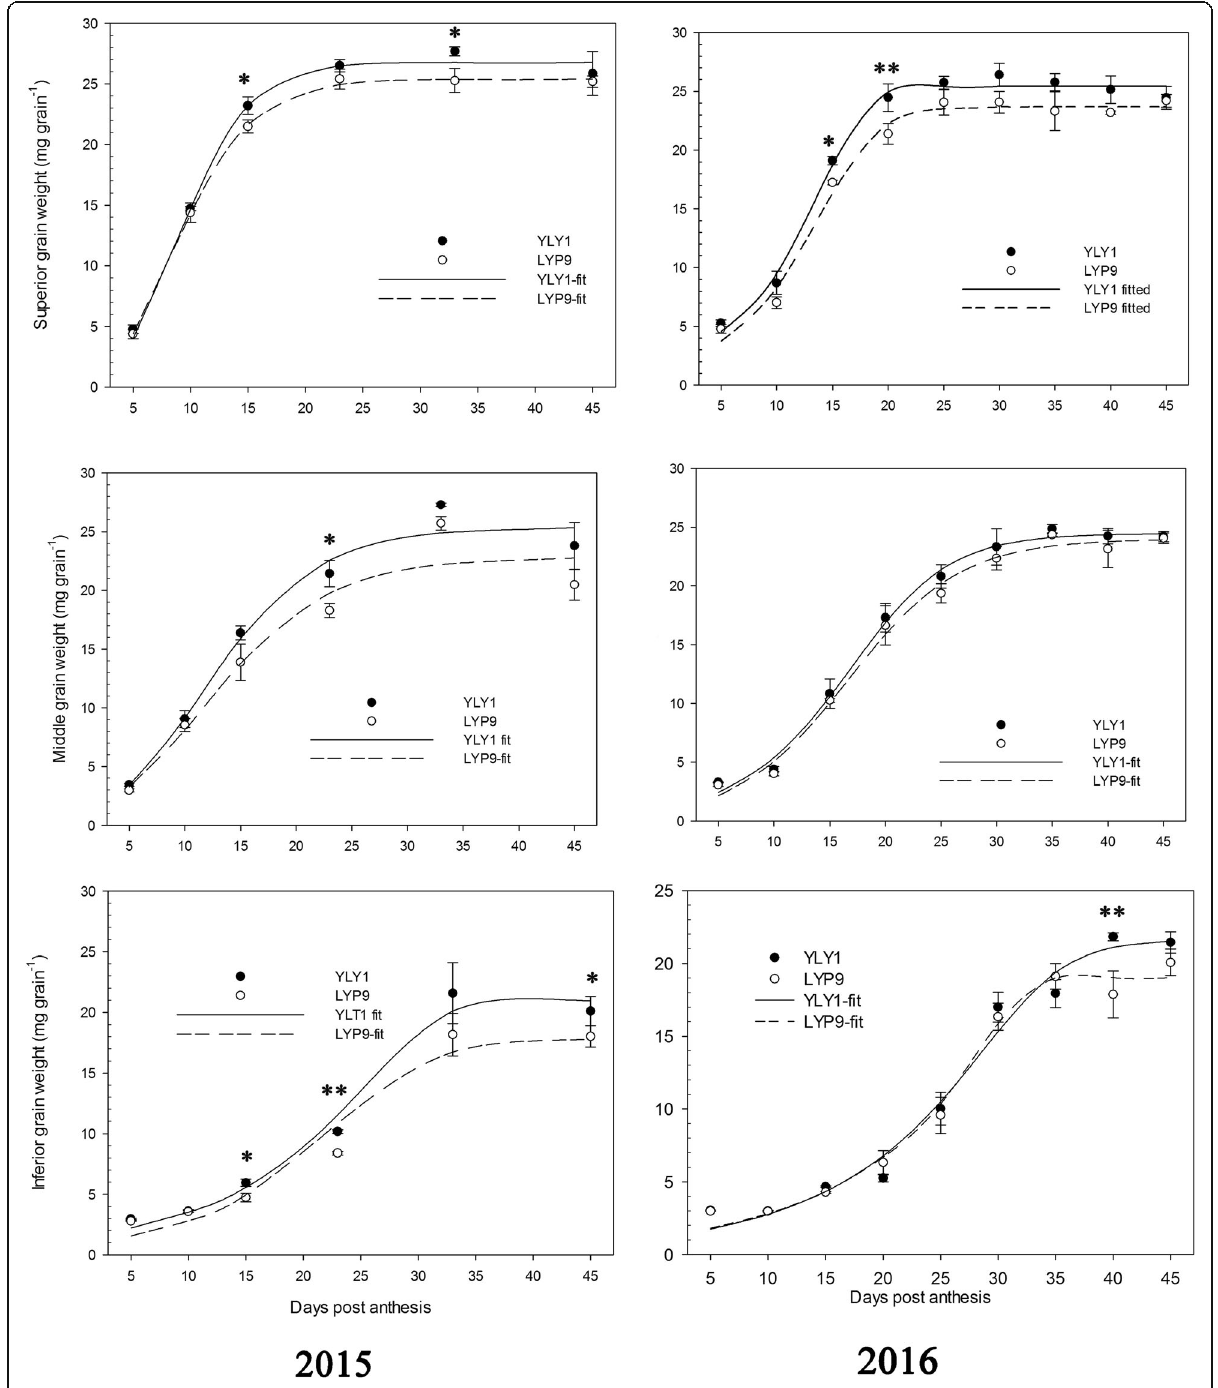
Fig. 8 The changes of superior, middle and inferior grain weights along developmental progression after anthesis in 2015 and 2016. a Superior grain weight in 2015; b Superior grain weight in 2016; c Middle grain weight in 2015; d Middle grain weight in 2016; e Inferior grain weight in 2015; f Inferior grain weight in 2016. “ *, ” “ ** ” represent significance levels of p = 0.05 and p = 0.01 levels, respectively. The bar represents the standard deviation of 10